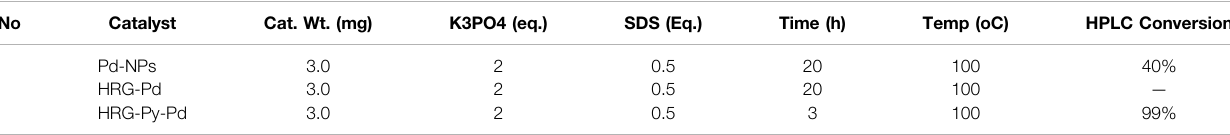
TABLE 5| Comparison ofthereactionyieldofMizoroki-Heckreaction catalyzedbypristinePd-NPs,HRG-Pd,andfunctionalizedHRG-Py-Pdnanocatalystsusingthesame amount of catalysts under similar reaction conditions. Sl. No